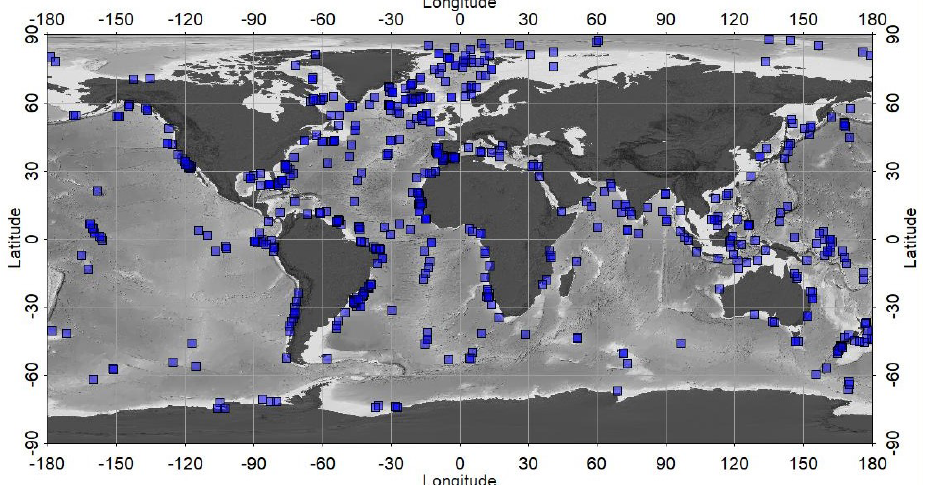
Figure 9. Spatial distribution of stable isotope records with at least one radiocarbon age. The map has been generated with PaleoDataView (Langner and Mulitza, 2019).